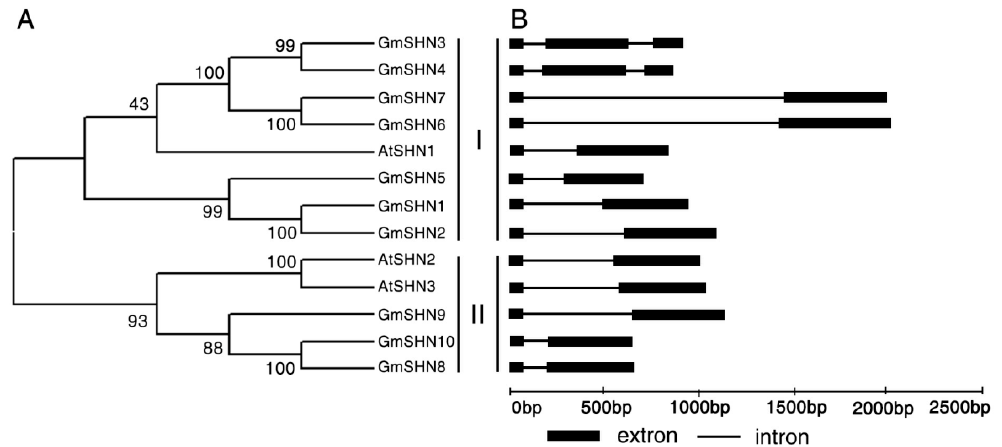
Figure 2. Sequence and gene structure analysis of soybean SHN homologs with Arabidopsis SHN proteins. ( A ) Phylogenetic analysis of 10 soybean SHN proteins and 3 Arabidopsis SHN proteins.